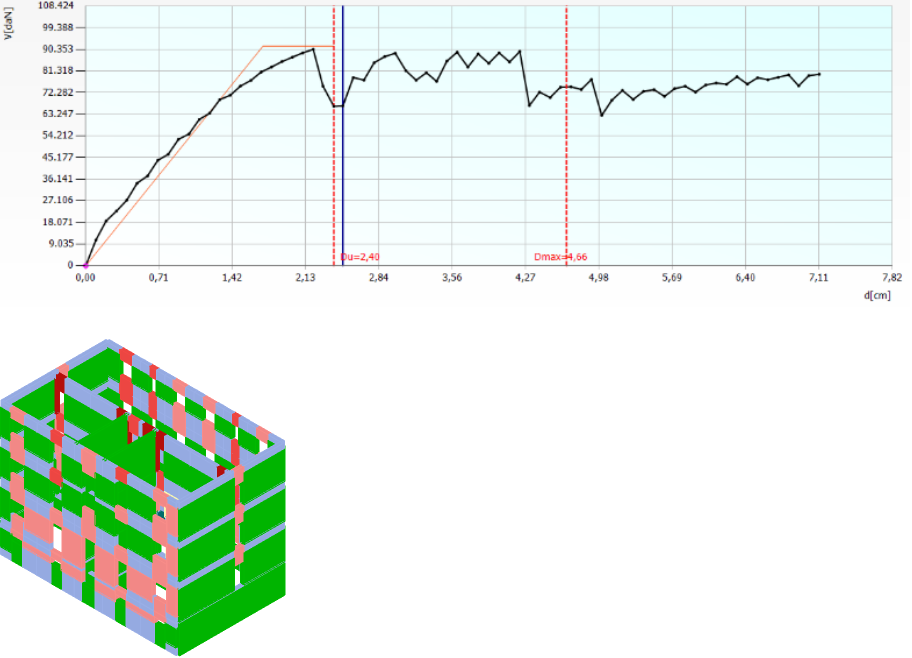
Figure 11. Results of analysis No. 2 in X-direction on the bare building.